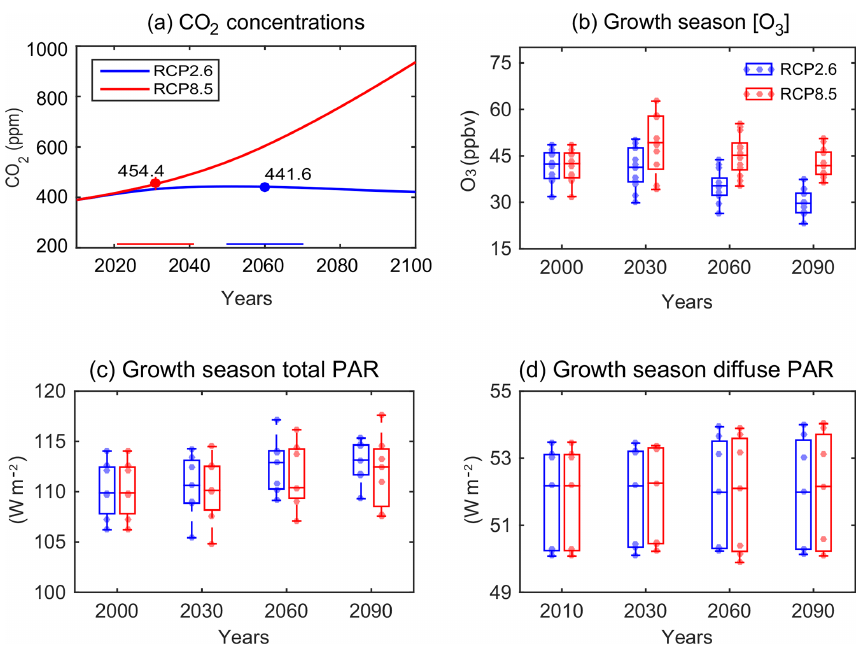
Figure 3. Changes in atmospheric compositions and radiation. Results shown are projected future (a) global CO 2 concentrations, and (b) surface O 3 concentrations, (c) total photosynthetically active radiation (PAR), and (d) diffuse PAR at growth season in China. The average (a) CO 2 concentrations at the global warming of 1.5 ◦ C are 442ppm for RCP2.6 scenario (blue, 2050–2070) and 454ppm for RCP8.5 scenario (red, 2021–2041). The (b) O 3 concentrations are averaged over east of 110 ◦ E in China from 12 ACCMIP models for RCP2.6 (blue) and RCP8.5 (red) scenarios. Each dot represents the value averaged for May to September from a chemistry model. The (c, d) PAR values are averaged over China from seven CMIP5 models for RCP2.6 (blue) and RCP8.5 (red) scenarios. Diffuse PAR is calculated using hourly total PAR and solar zenith angle based on the parameterization M01. Each dot represents the value averaged for May to September from a climate model. For each selected year in (b–d) , a period of 11 years (5 years before and 5 years after) is used to derive the decadal mean